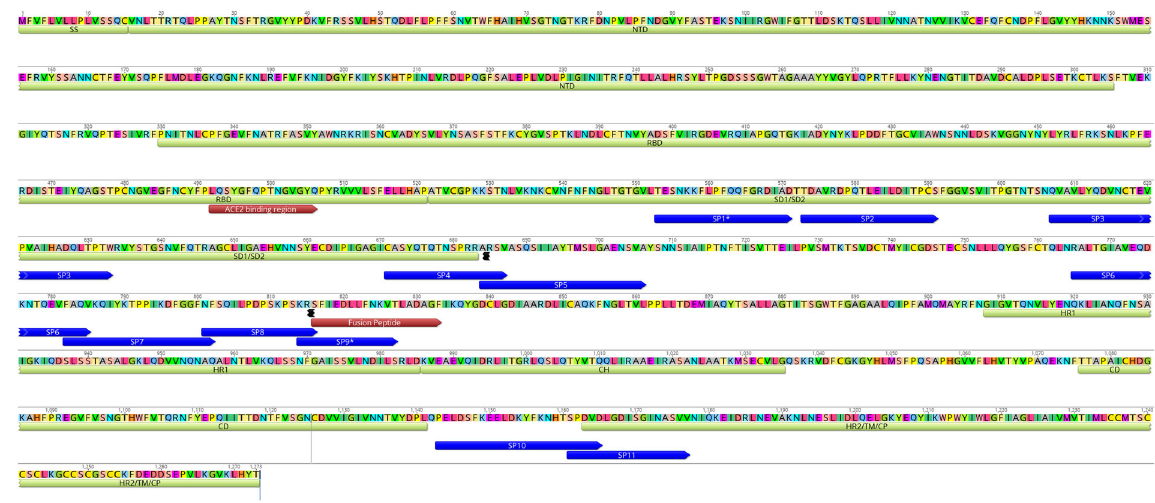
Fig. 2 Mapping of eleven spike epitopes identi fi ed in this study on the surface glycoprotein of SARS-CoV-2 [GenBank: QHD43416.1]. Location of Spike epitopes (SP1-SP11) is shown that in dark blue arrows. Primary structure domains are colored by green bars: SS, signal sequence; S2 ′ , S2 ′ protease cleavage site; FP, fusion peptide; HR1, heptad repeat 1; CH, central helix; CD, connector domain; HR2, heptad repeat 2; TM, transmembrane domain; CT, cytoplasmic tail. “ { ” symbols indicate protease cleavage sites. Brown arrows denote ACE2-binding region and fusion peptide regions. *Epitopes with neutralizing antibody binding potential (SP1*, and (Supplementary Fig. 3, Supplementary Table 5, Supplementary Data 8).